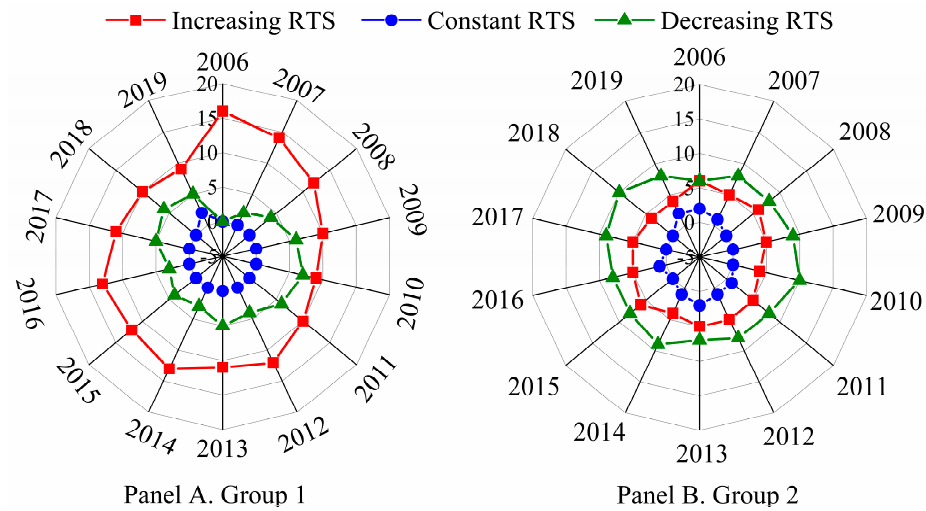
Figure 6. The number of DMUs belonging to the three RTS types.